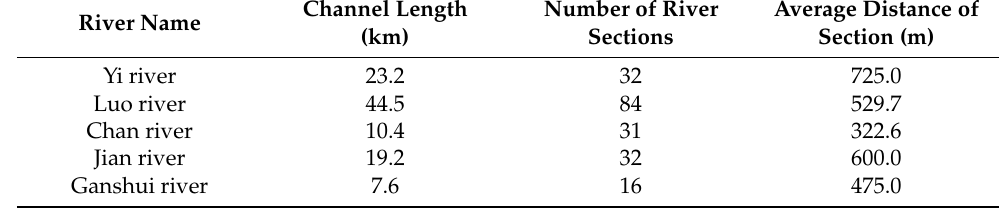
Table 1. Basic information of Yi, Luo, Chan, Jian and Ganshui rivers.